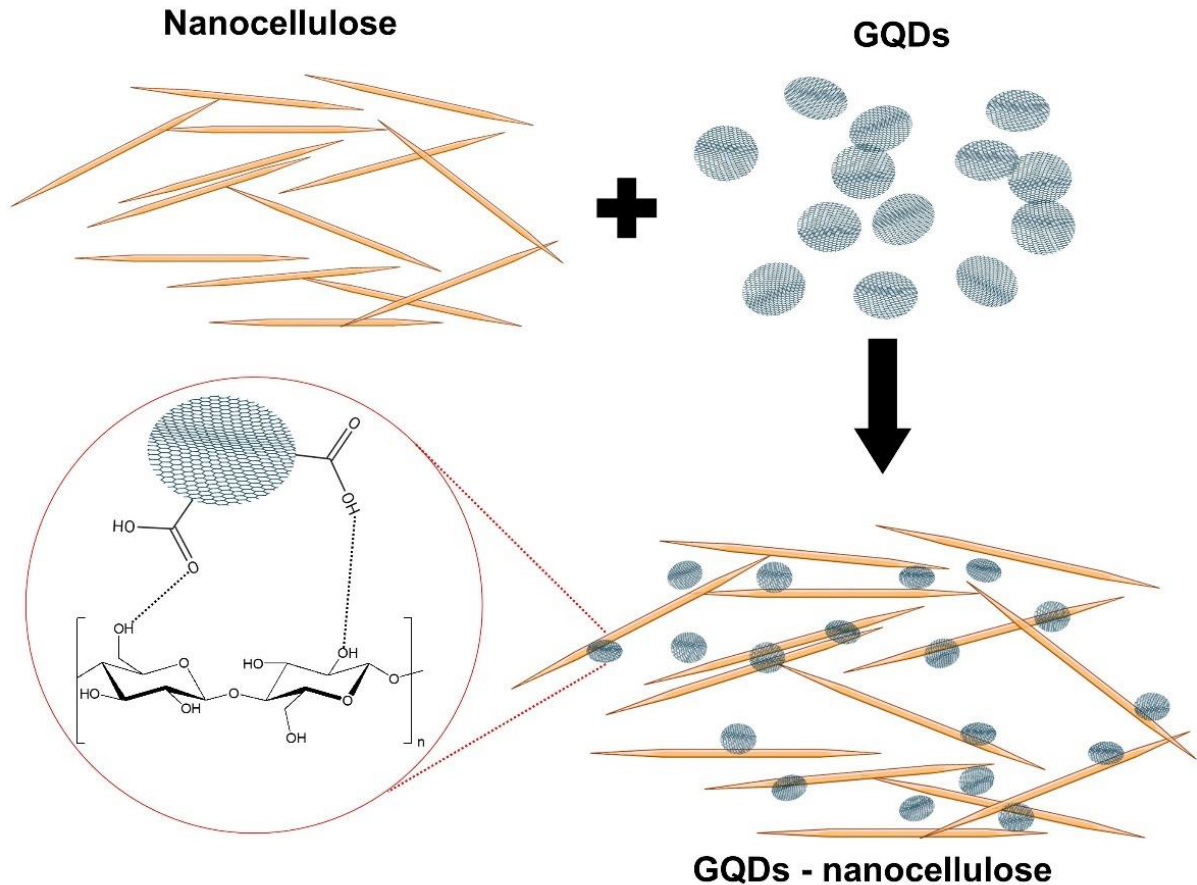
Figure 4. A schematic illustrating the interaction and formation of the hydrogen bonding between the carboxyl groups of graphene quantum dots (GQDs) and the hydroxyl groups of nanocellulose.